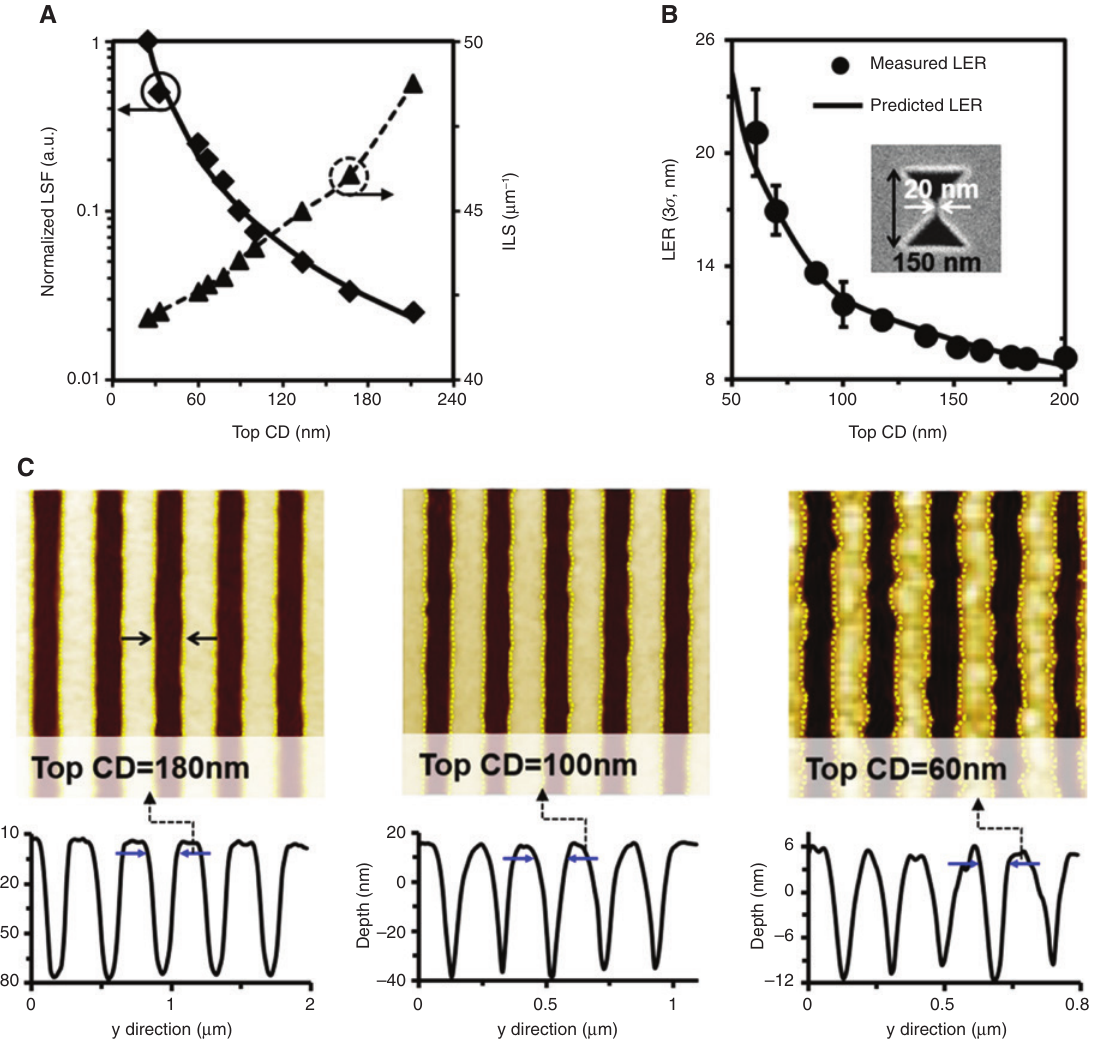
Figure 4: LER estimation and characterization. (A) Comparison of the (solid diamonds) measured and (solid line) calculated LSFs of the photoresist obtained using the convolutional relationship between the photoresist PSF and a line image and the calculated ILS as a function of feature size. (B) LER as a function of the top CD of the generated line pattern. (Solid circles) Measured and (solid line) predicted LERs. The error bars show the standard deviations ( < 3%) of the measured LERs. The inset shows the scanning electron microscopy(SEM) image of the used bowtie-shaped nanoaperture. (C) AFM images of the line patterns with various top CDs (the black arrows show the measured top CD). The generated LER is very clearly dependent on the feature